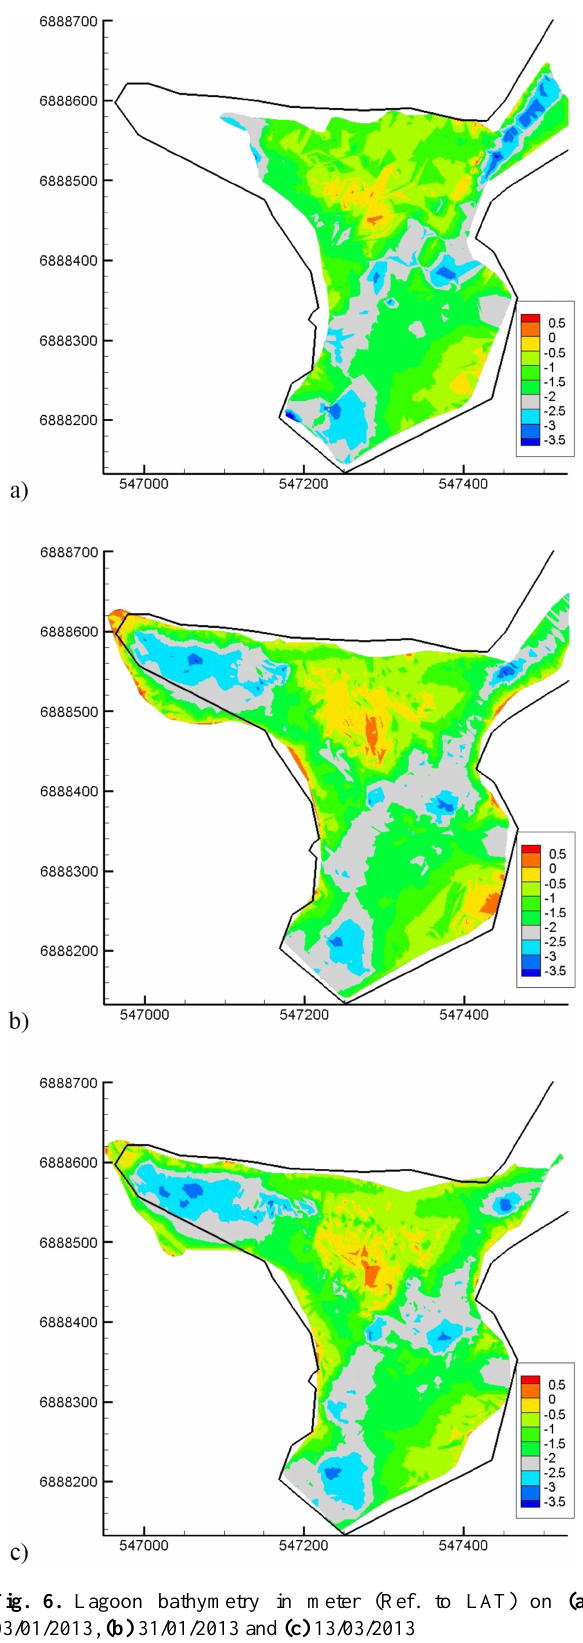
Fig. 6. Lagoon bathymetry in meter (Ref. to LAT) on (a) 03/01/2013, (b) 31/01/2013 and (c)